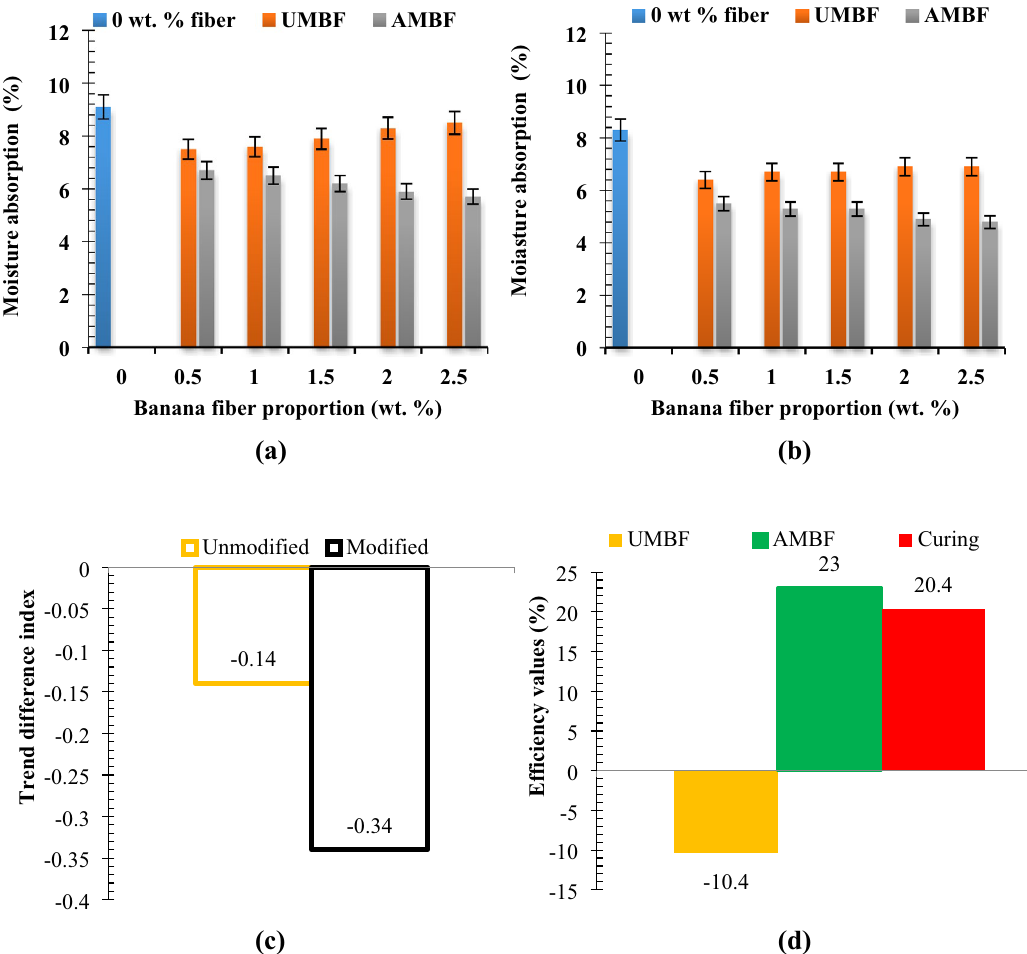
Figure 5. Relation between fiber proportion of unmodified and modified fiber and moisture absorption at curing days of ( a ) 28 days and ( b ) 56 days with ( c ) experimental trend analysis and ( d ) property evaluation of experimental